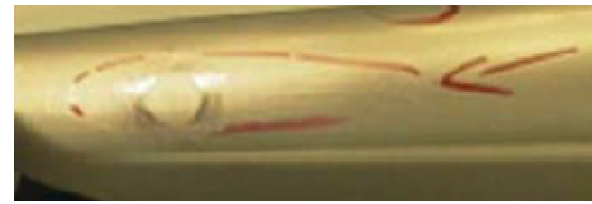
Figure 1. Defect example: dent Dents are visible depressions on the surface.